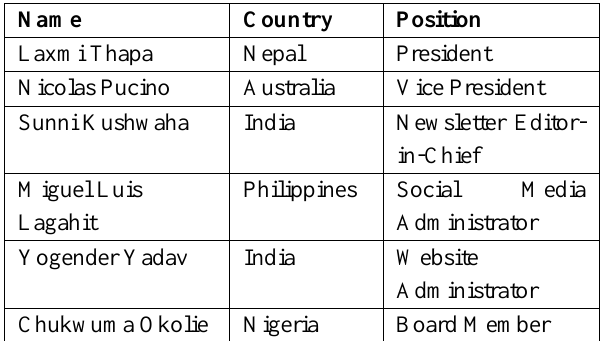
Table 1. The elected Board of Directors for the term 2022 -